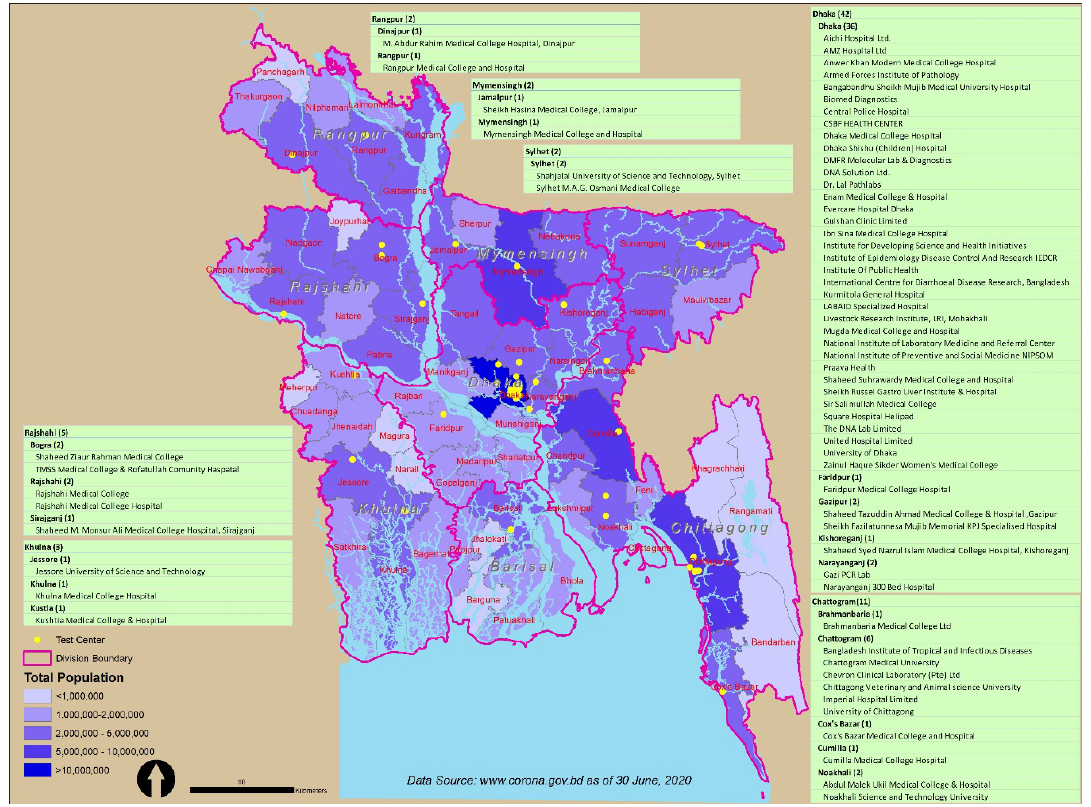
Figure 5. Map of Bangladesh demonstrating the spatial distribution of COVID-19 testing centers (currentlyoperatingasof6July2020)inthecountry. Source: Authorsillustrationbasedonthegeographic information systems (GIS) and Coronavirus COVID-19 Dashboard,